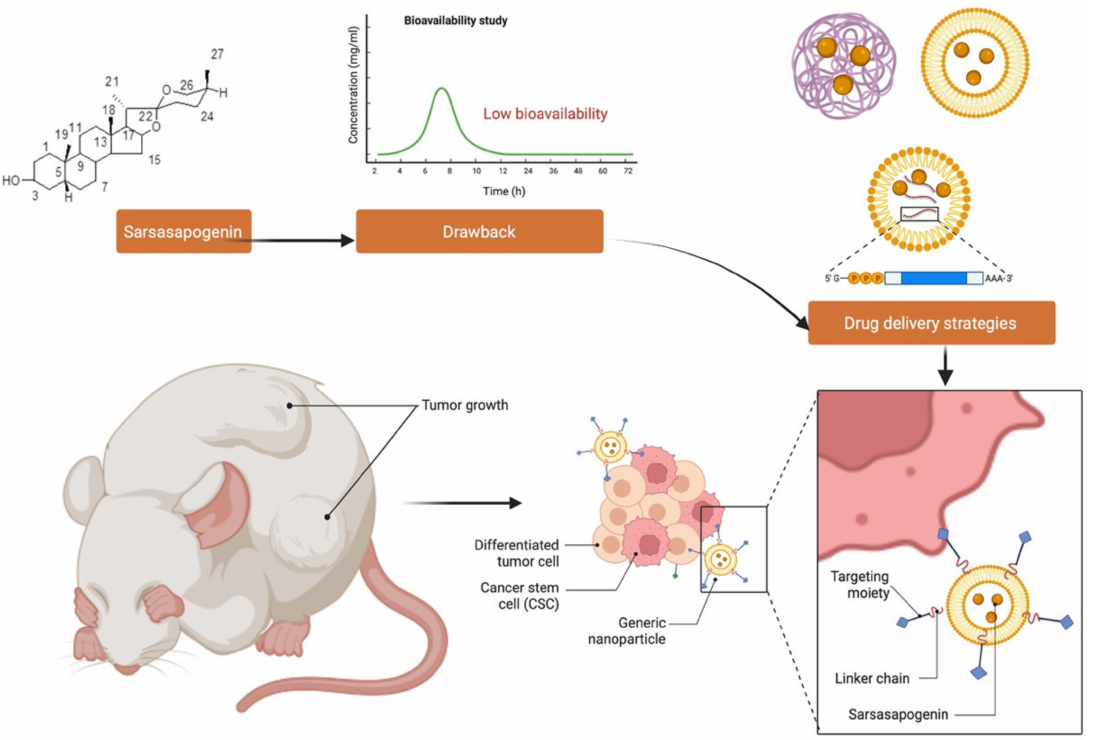
Figure 10. Schematic representation of the drug delivery strategy for sarsasapogenin-loaded lipo- somes augmented with a targeting moiety, such as cell-penetrating peptides (CPPs), to enhance localisation and bioavailability of the bioactive